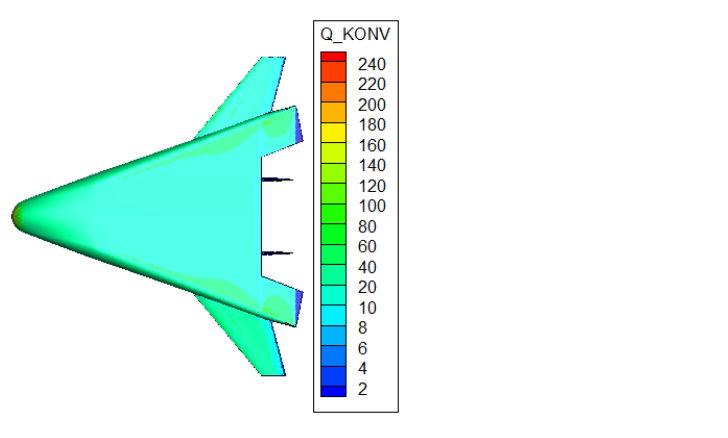
Figure 2. Distribution of convective heat flux q w (kW/m 2 ) for the lower part of the X-33, Mach number M = 6, height H = 25 km, attack angle α = 10 ◦